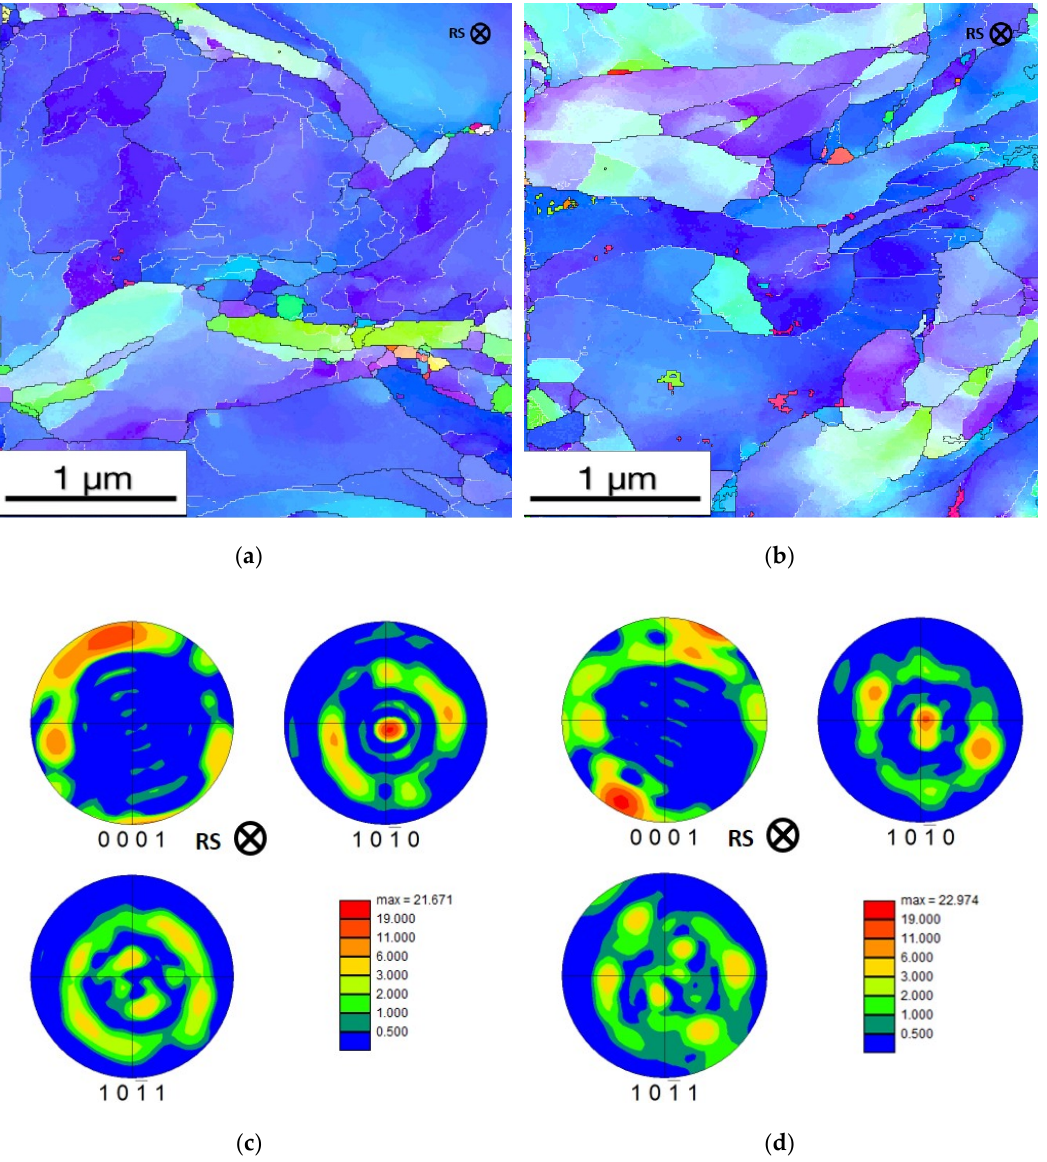
Figure 14. ( a , b ) Grain orientation maps and ( c , d ) corresponding (0001), (101 ̅ 0), (101 ̅ 1) pole figures for Conform SPD + rotary swaged (true strain of 1.6) titanium Grade 2 and Grade 4, respectively (direction of rotary swaging indicated as “RS”, perpendicular to the plane of the sheet).